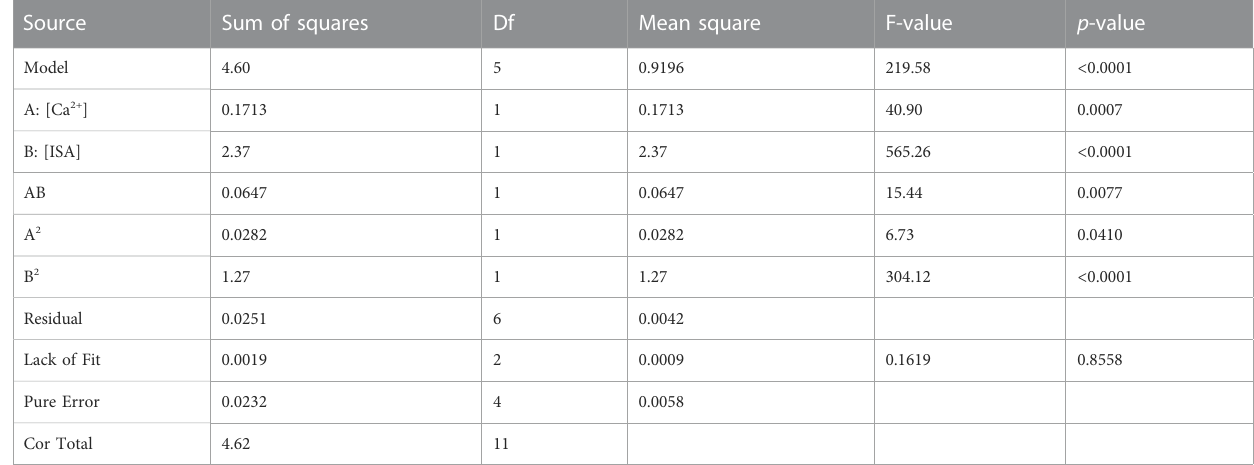
TABLE 8 ANOVA of the model for the log Rd-value of Pu on CILVA excluding Run 6.